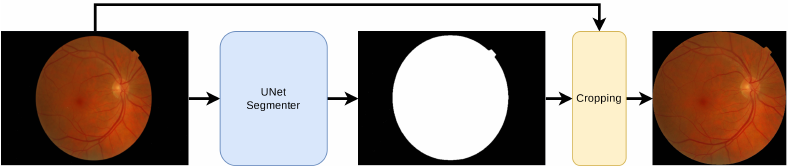
Figure 3. Flowchart for the pre-processing of an RFI. The input image is of size H × W. An automatic segmentation model detects the retinal circle. The max and min coordinates are obtained in X and Y used as a reference to remove the background. Zero padding is then added if necessary. The output is an image of H × H with an aspect ratio of